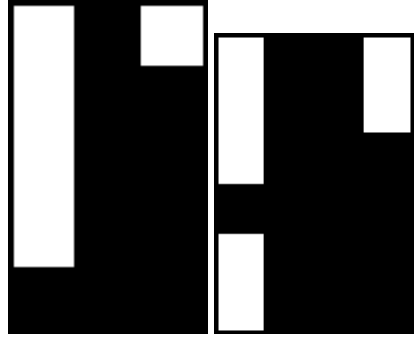
( a ) Sample resulting image with two people.